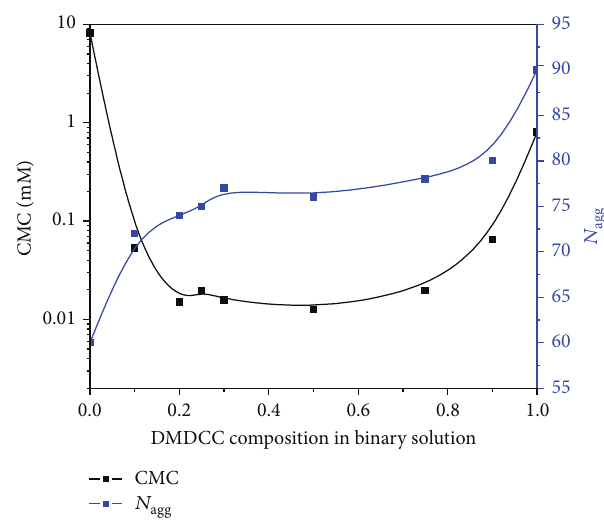
Figure 1: Variation of critical micelle concentration of DMDCC- SDS binary mixture system as a function of DMDCC mole fraction ( 𝑇 = 50 ∘ C).